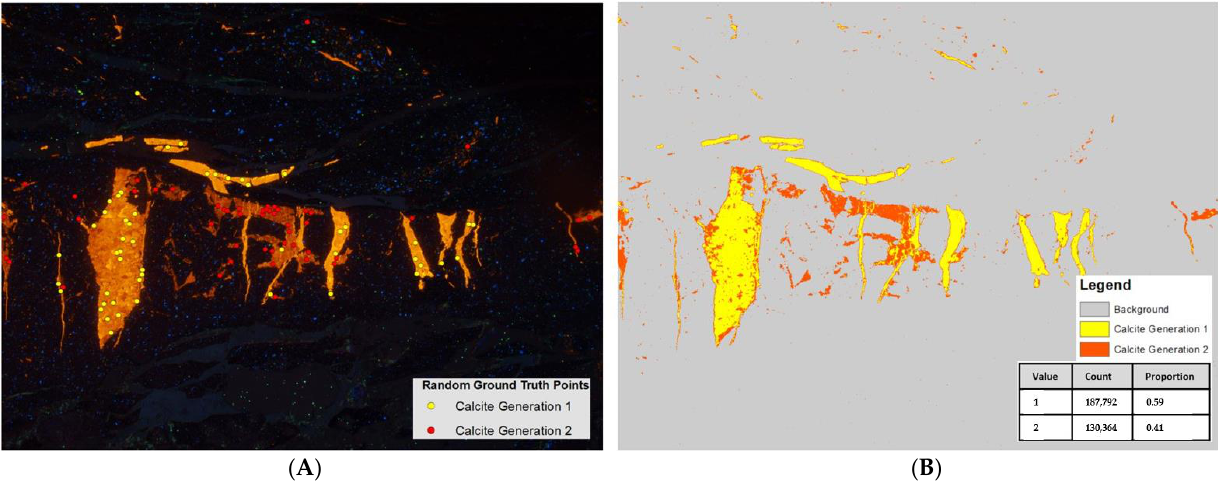
Figure 8. Results of unsupervised classification showing ( A ) the input CL image, randomly generated accuracy assessment points (n = 100), and ( B ) the classified output with counts of pixels assigned as either calcite generation 1 or 2.